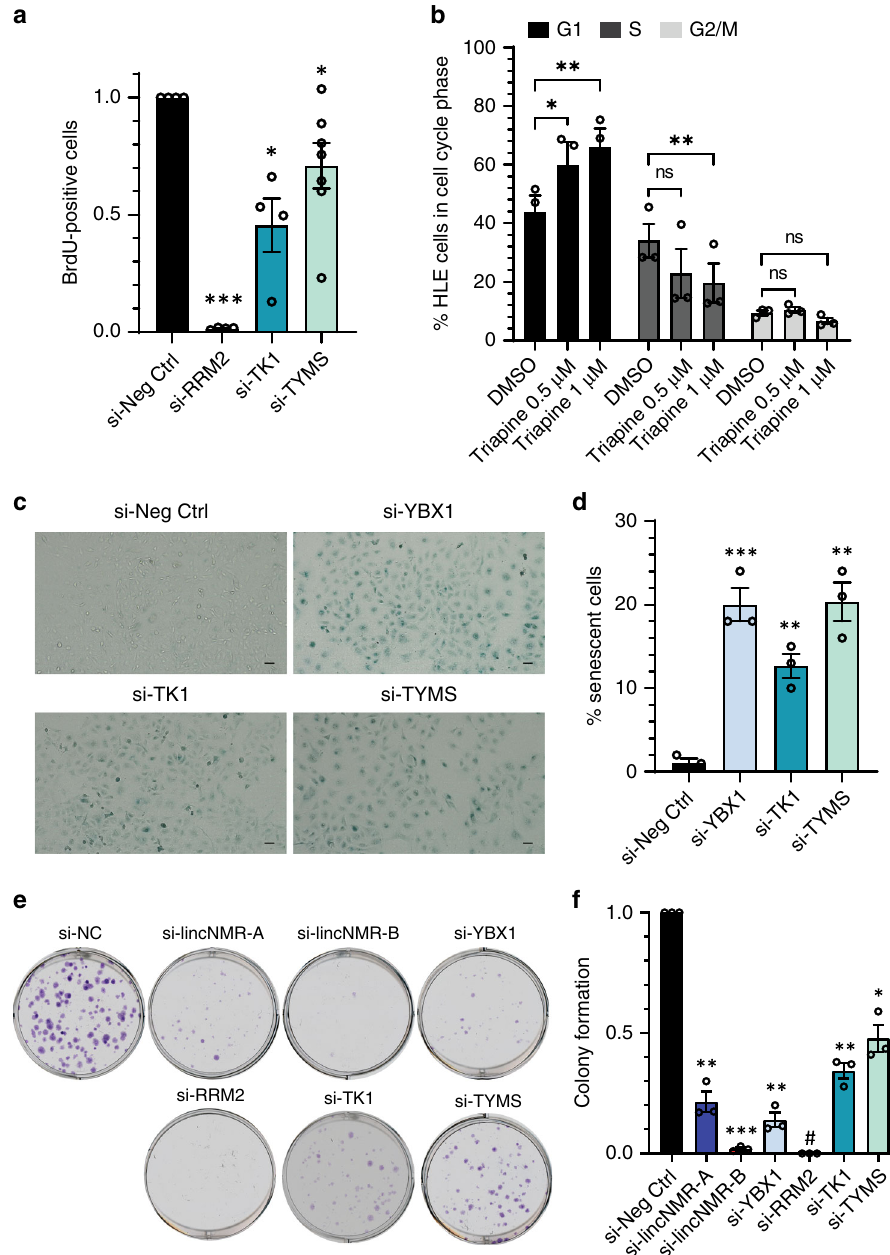
Fig. 5 Silencing YBX1, RRM2, TK1 , or TYMS mimics the phenotype of lincNMR depletion. a Depletion of RRM2, TK1, and TYMS invokes a strong proliferation defect 72 h after knockdown using 10 nM siPOOLs targeting RRM2, TK1, or TYMS in HLE cells in at least three biological replicates. b The RRM2 inhibitor Triapine (0.5 µ M and 1 µ M) induces cell cycle arrest in the G0 / G1 phase at 72 h post treatment in HLE cells. DMSO was used as a control. Data analysis was performed using the cell cycle analysis platform in the FlowJo software v10 ( n = 3). c Representative microscopic images showing increased β -Gal activity indicating induction of senescence in HLE cells at 96 h post knockdown with 10 nM of the respective siPOOLs ( n = 3). The scale bar represents 100 µ m. d SA- β -Gal assay quanti fi cation: bar graph representing percent β -Gal-positive cells after depletion of YBX1, TK1, and TYMS in HLE cells ( n = 3). RRM2-depleted cells were abolished, and hence not available for analysis. e Representative images showing the impact of silencing of lincNMR , YBX1, RRM2, TK1, and TYMS on colony-forming ef fi ciencies at 10 days after transfection using 10 nM siPOOLs in HLE cells ( n = 3). f Quanti fi cation of colony formation after knockdown represented relative to the negative control siPOOL ( n = 3). #: Following RRM2 knockdown, no colonies were growing (0) and hence, no statistical signi fi cance could be calculated. a , b , d , f Data represent mean, and error bars represent SEM. Signi fi cance was calculated by unpaired, two-tailed t test with * P < 0.05; ** P < 0.01; *** P < (thymidine kinase), and TYMS (thymidylate synthetase) among Deregulation of nucleotide metabolism has been reported to play a other cell cycle regulators and proliferation markers. These are also pathogenic role in various diseases, including cancer 50,51 . In our triple-label SILAC-MS, knockdown of lincNMR leads to induced in HCC, associated with poor survival, and correlated with strong downregulation of key enzymes essential for dNTP bio- lincNMR expression, and their knockdown phenocopies the effect synthesis — RRM2 (ribonucleotide reductase subunit 2), TK1 of lincNMR on cell proliferation, senescence, and colony formation.